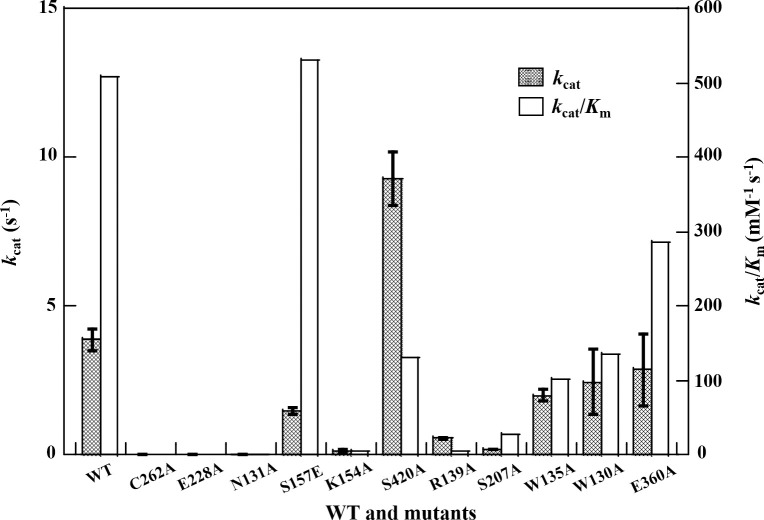
The kcat and kcat/Km values of cce4228 wild-type and mutants with NADP+ as cofactor.